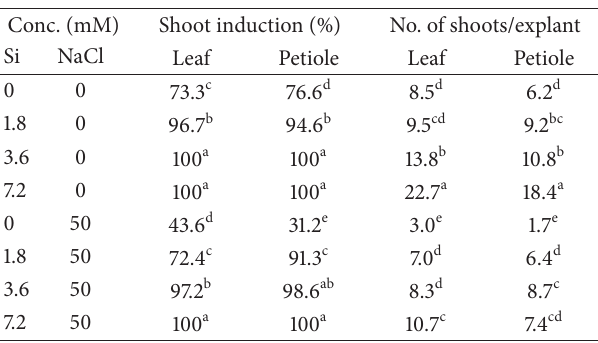
Table 1: Effect of 2-iP and NAA on adventitious shoot regeneration from leaf and petiole explants of A. multiflora .